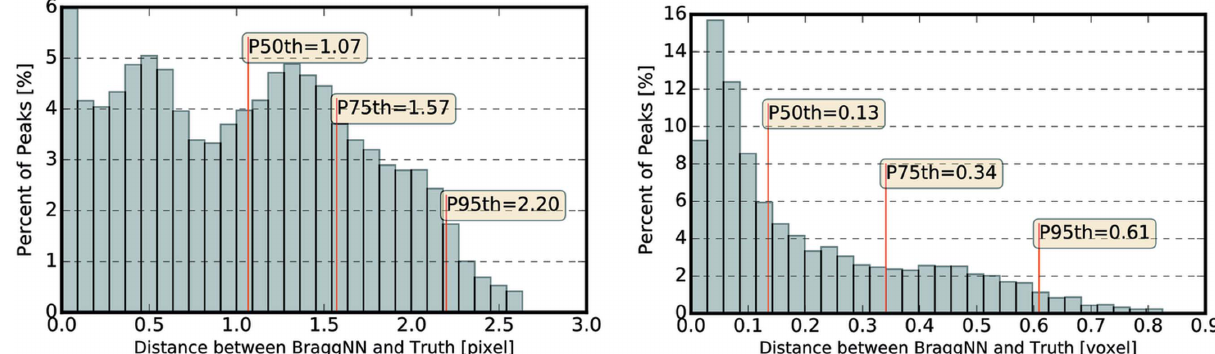
Figure 8 Peaks located by BraggNN when peaks deviate from the geometric center. The error is the Euclidean distance ( ‘ BraggNN prediction (dotted-line cross). Upper row: using BraggNN trained without data augmentation. Bottom row: using BraggNN trained with data augmentation for the same peaks as the upper